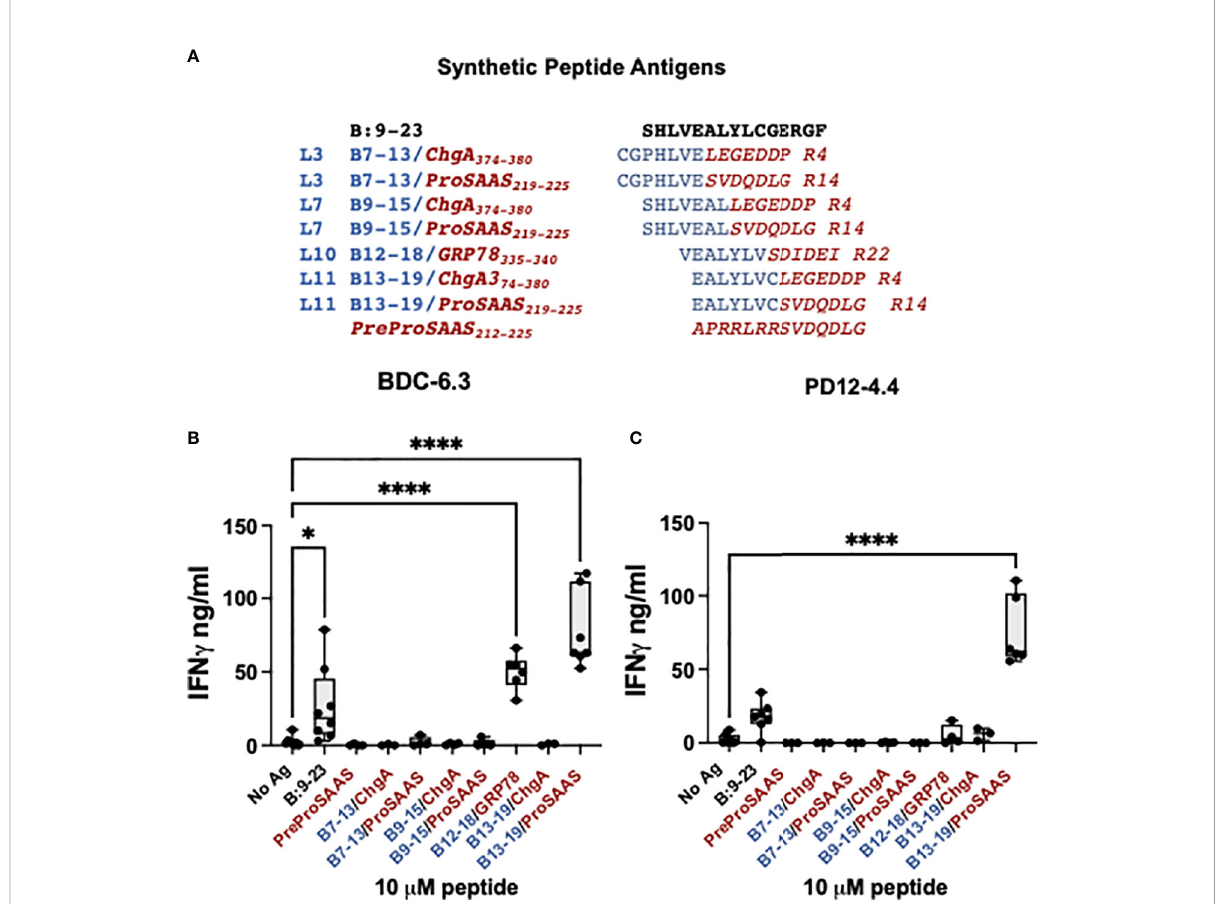
FIGURE 2 BDC-6.3 IFN- g response to candidate B-chain HIP antigens. (A) Synthetic peptides representing the highest scoring peptides within the Left and Right peptide libraries. Blue = B:9-23 derived peptides, red italics = natural cleavage product peptides from other ß-cell proteins. The PreProSAAS peptide is 14 amino acids spanning a dibasic proteolytic processing site and was included as a negative control. (B) IFN- g responses of T cell clone BDC-6.3 to 10 µM concentrations of B:9-23 or synthetic B-chain HIP candidates. (C) IFN- g responses of T cell clone PD12-4.4 to 10 µM concentrations of B:9-23 or synthetic B-chain HIP candidates. Compiled data is shown for the average of 3-8 experiments (BDC-6.3) or 3-7 experiments (PD12-4.4), with statistical analysis using a one-way ANOVA with Dunnett ’ s multiple comparison test *P<0.05, ****P<0.0001 where the box de fi nes the interquartile range, and the whiskers indicate minimum and maximum